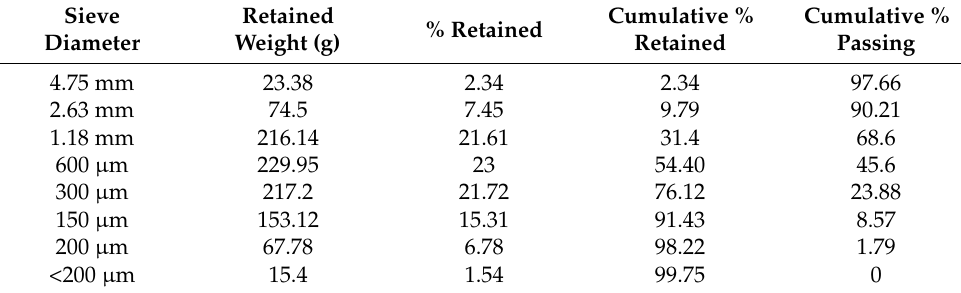
Table 2. Grading analysis of fine